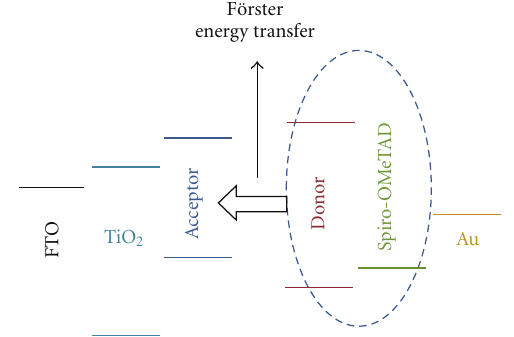
Figure 14: Depiction of energy level positions of FRET-type solid- state dye-sensitized solar cell (SS-DSSC) constituents. Reprinted with permission from